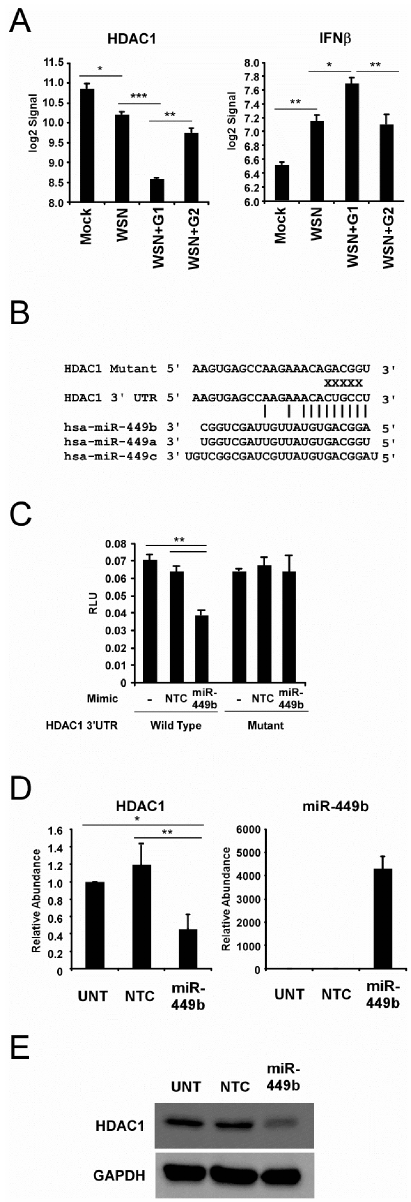
Figure 4. MiR-449b regulates HDAC1 mRNA and protein expression. (A) HDAC1 and IFNβ are regulated by influenza-induced miRNAs. Histograms illustrating the average microarray signal for HDAC1 (left) and IFNβ (right) in the presence or absence of miRNAs described in Figure